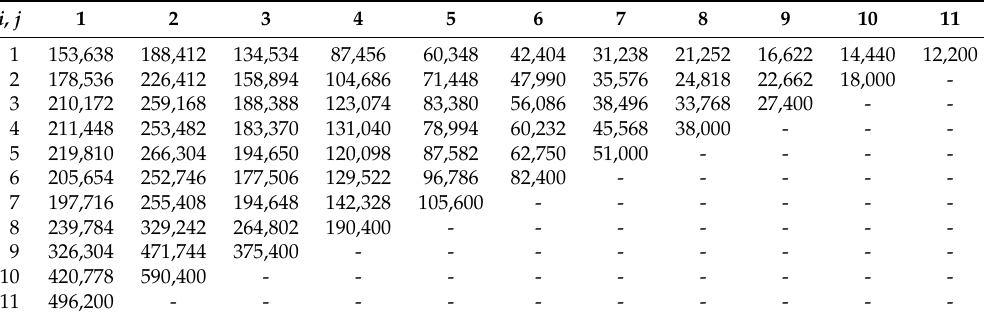
Table A1. Insurance run-off triangle taken from Barnett and Zehnwirth (2000, Table 3.5) as used in the empirical application in Section 6.2 and the simulations in Section